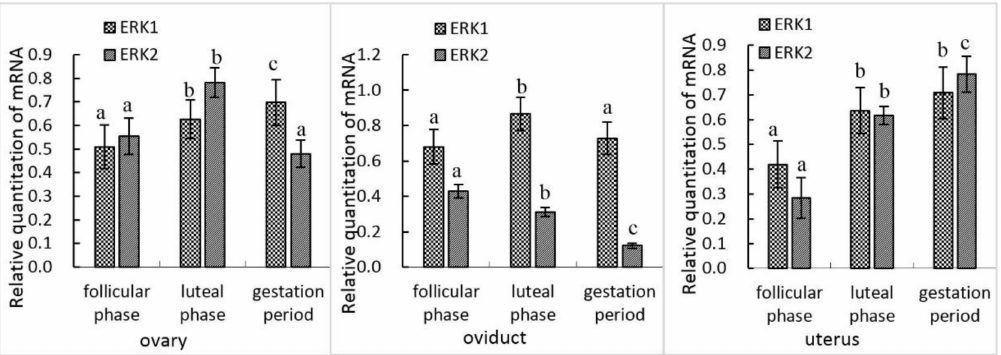
Figure 1. Expression of extracellular signal-regulated kinase ( ERK)1 and ERK 2 mRNA in female reproductive organs at di ff erent stages. In a certain reproductive organ, the di ff erence of the same protein between a and b or b and c is significant (0.05 > p > 0.01), and the di ff erence of the same protein between a and c is extremely significant ( p <